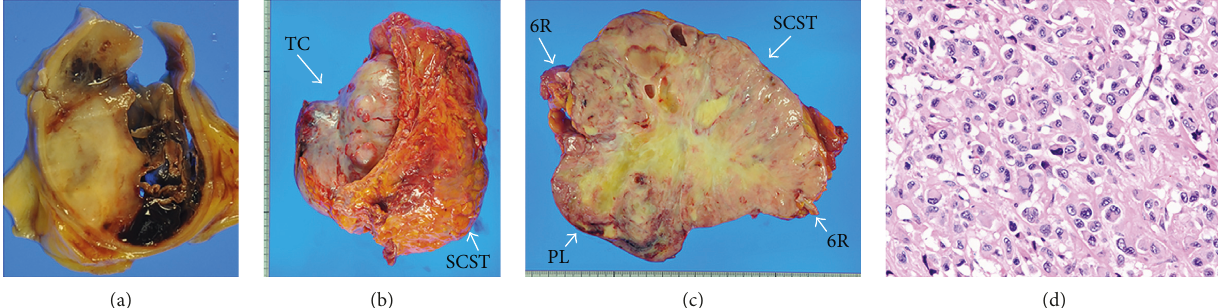
Figure 3: Pathological findings at autopsy. Macroscopic observation of the transverse cut surface of the right pulmonary artery showed the vascular lumen filled with the solid tumor and secondary thrombus (a). Gross appearance of the chest wall tumor that is occupying the full thickness from the soft tissue through the thoracic cavity (b). The cut surface of the chest wall tumor appeared as a white-colored solid mass with central necrosis (c). The left 6th rib bone showed the tumor with complete osteolysis. Microscopic observation in the pulmonary artery tumor showed that the tumor was predominantly composed of pleomorphic, multinucleated round tumor cells with an incohesive nature (d). TC, thoracic cavity; SCST, subcutaneous soft tissue; PL, pleura; 6R, 6th rib